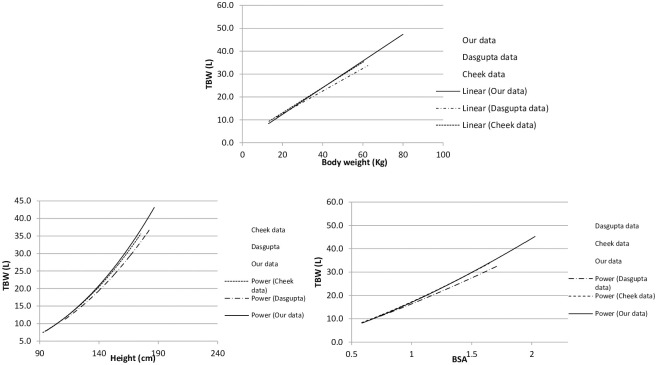
Comparison of regression line fits between bioimpedance and dilution methods.BSA: Body surface area Cheek et al14, Dasgupta et al15.